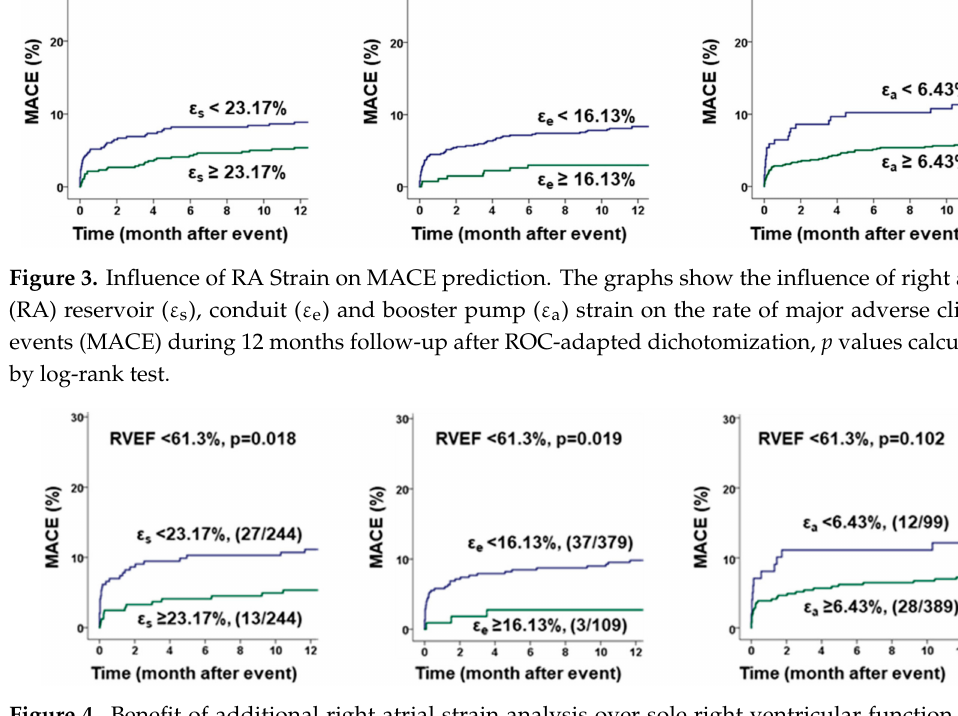
Figure 4. Benefit of additional right atrial strain analysis over sole right ventricular function. The graphs show the impact of right atrial (RA) reservoir ( ε s ), conduit ( ε e ) and booster pump ( ε a ) function evaluation on the occurrence of major adverse cardiac events (MACE). RA function was investigated in addition to right ventricular ejection fraction (RVEF) below the median. Cut-O ff s for RA strains were chosen for optimal sensitivity and specificity, and p values were calculated by log-rank test for the occurrence of major adverse clinical events (MACE) within 12 months after myocardial